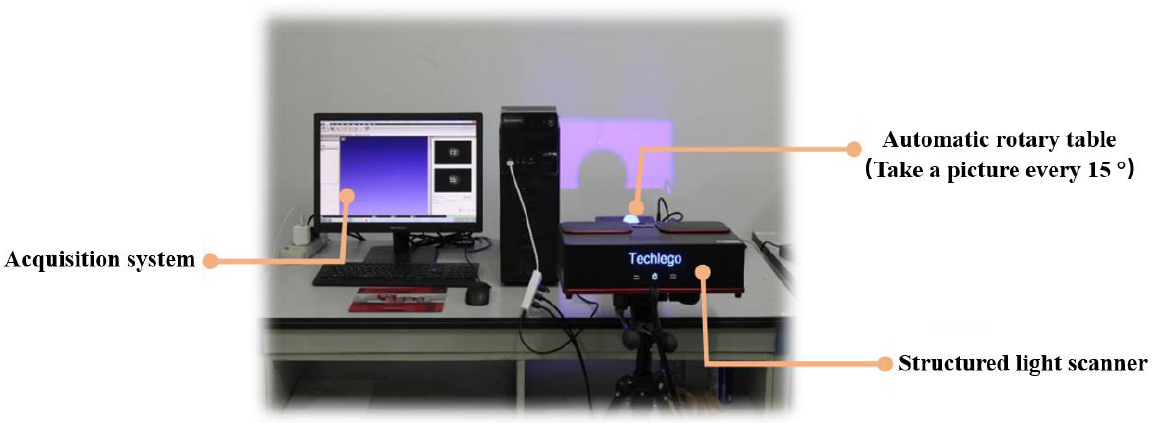
Figure 4. Laser positioning non-contact surface scanner.